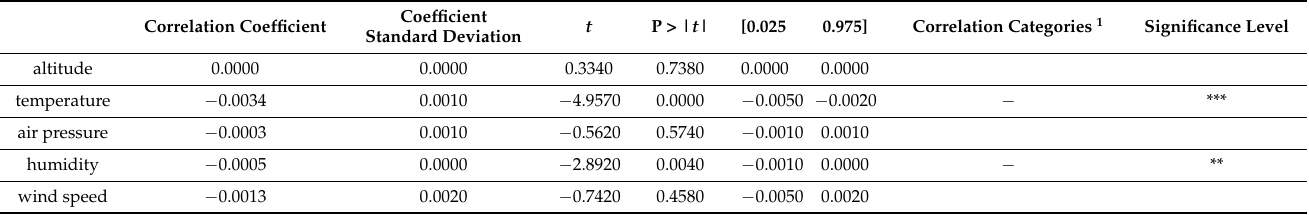
Table 3. The correlation performance of each feature when the dependent variable is average speed difference of Q3–Q4.